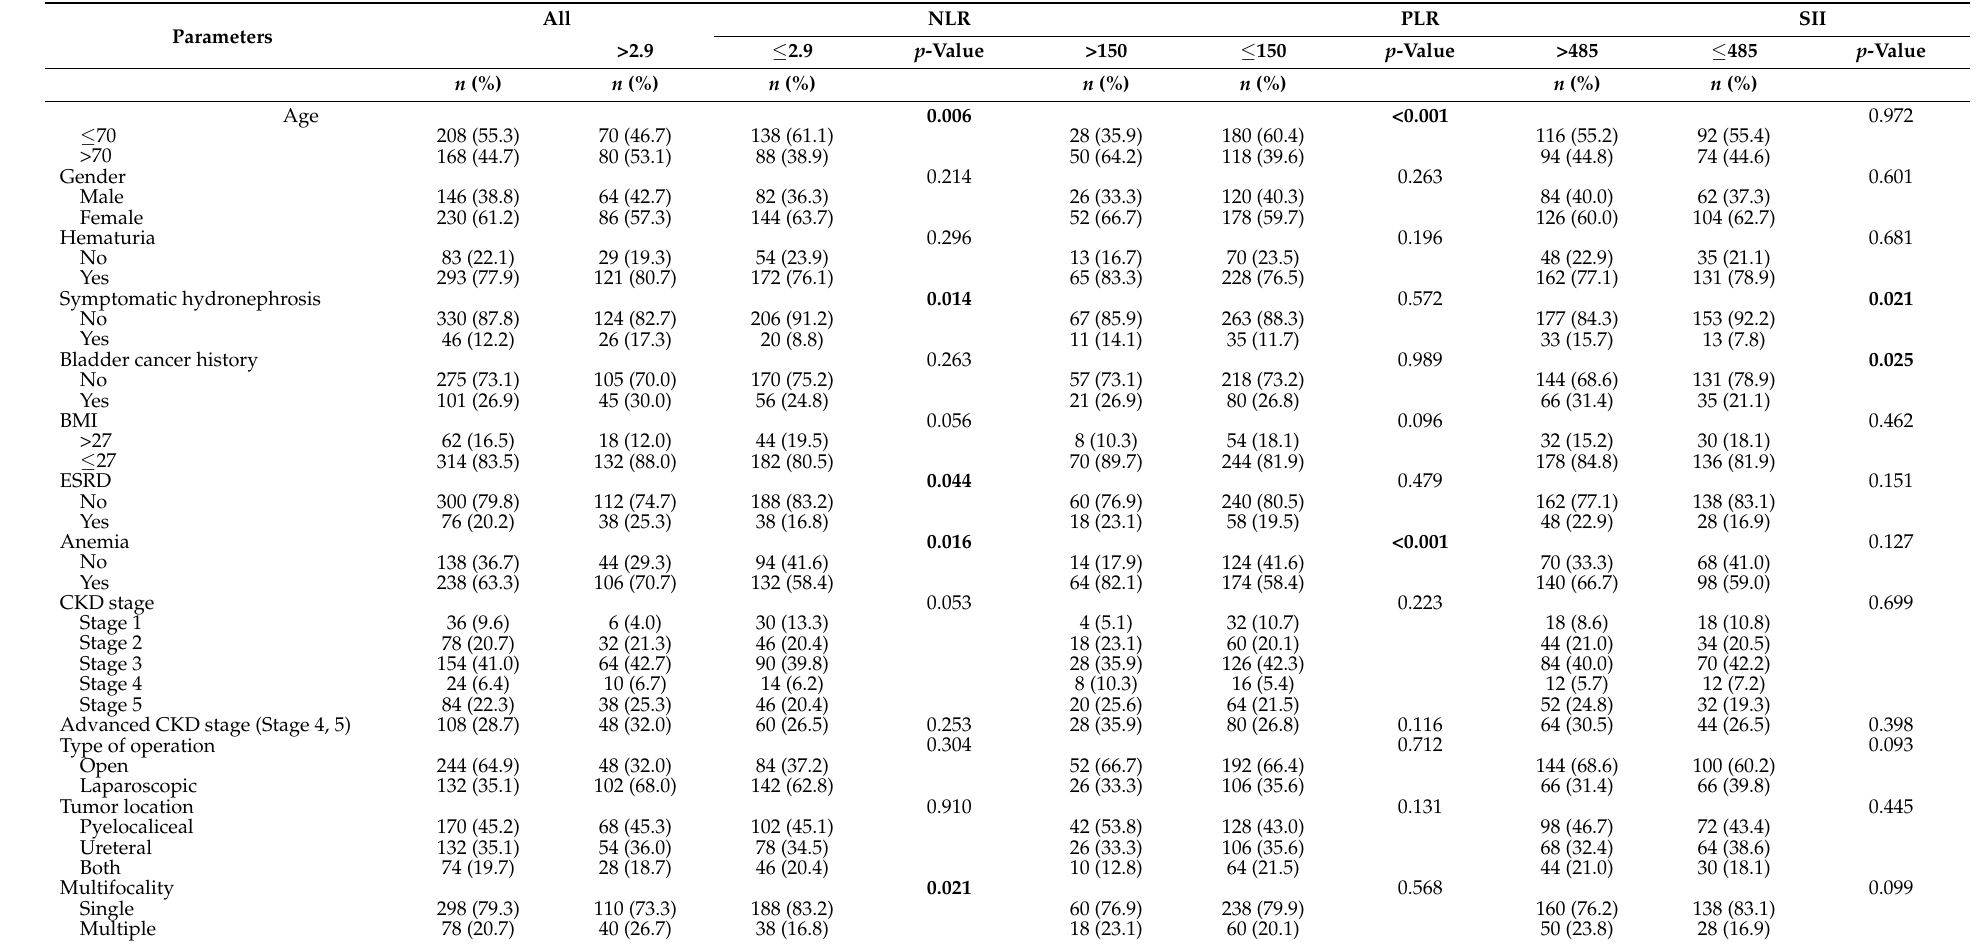
Table 1. Associations of NLR, PLR, SII and clinicopathologic characteristics in 376 patients treated with radical nephroureterectomy for upper tract urothelial carcinoma.